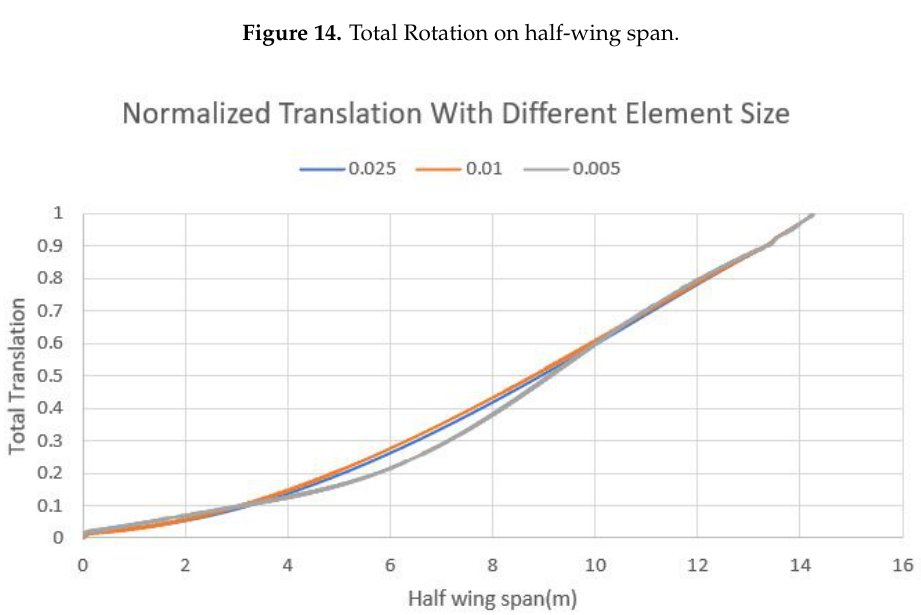
Figure 15. Total Translation for different Element size.